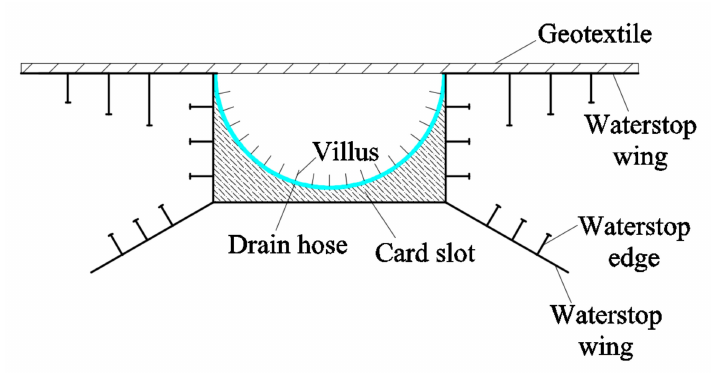
Figure 11. Structural diagram of “ π ” anti-crystallization drainage